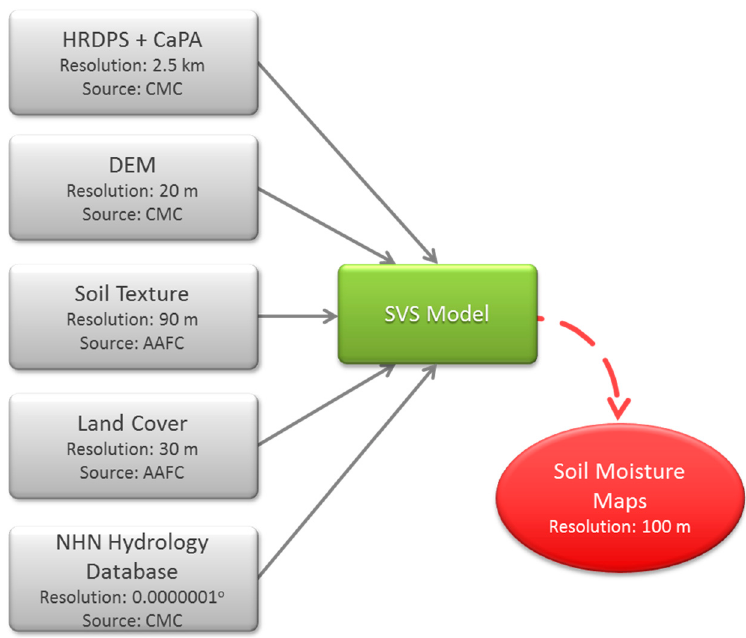
Figure 5. Flowchart of the soil moisture simulation process in using the SVS land surface model.